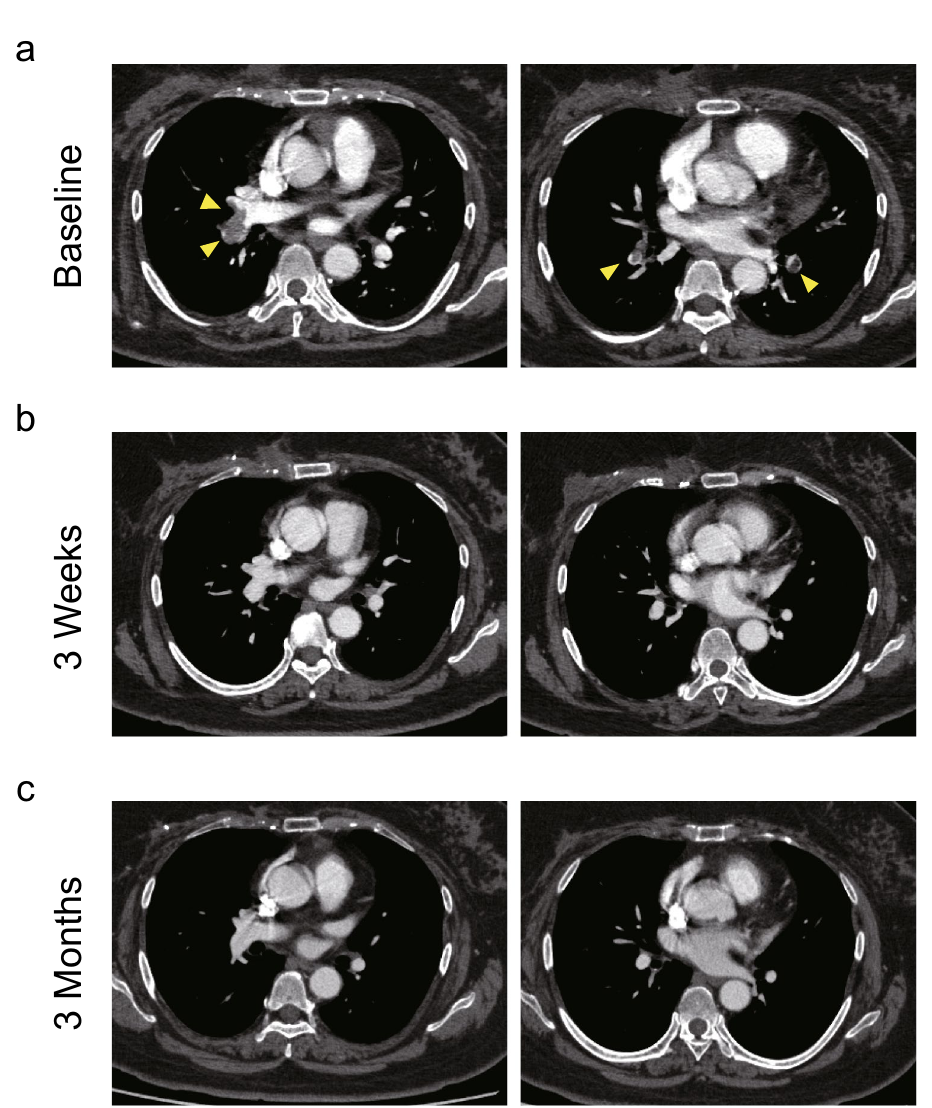
Figure 2. Representative CT scan images of pulomonry thromboembolism in patients with breast cancer who received rivaroxaban treatment. ( a ) Bilateral pulmonary thromboembolism were ditected by contrast-enhanced CT scan at baseline. Yellow arrows show thrombi in pulmonary artery. ( b ) After the treatment with rivaroxaban 30 mg for 3 weeks, pulmonary thrombi were disappeared, achieving complete thrombus resolution. ( c ) There were no venous thromboembolism reccurence after the treatment with rivaroxaban 15 mg for 3